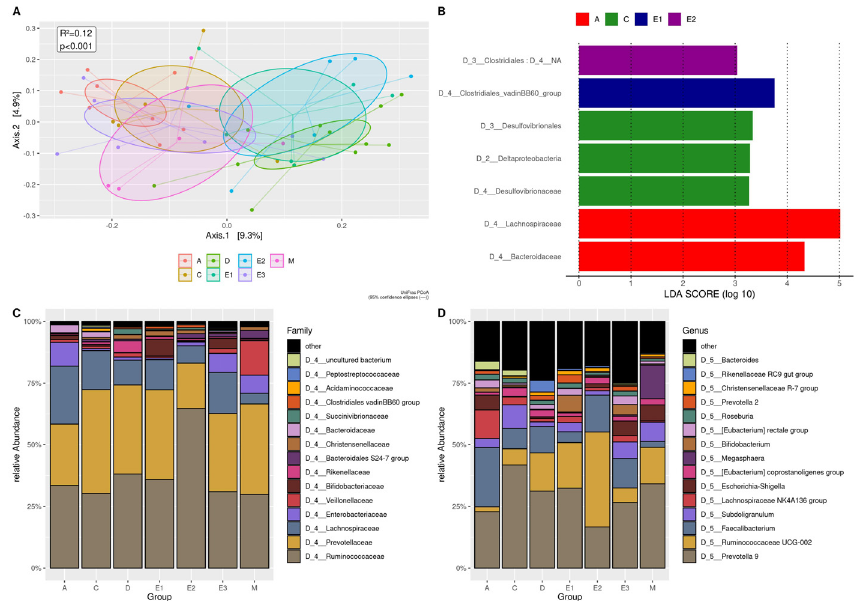
Figure 7. Beta diversity analysis for the subjects positive for G. duodenalis and other intestinal pathogens. Groups A: control group; Groups C: positive for Blastocystis only; Groups D: positive for Blastocystis and E. hartmanni without other pathogens; Groups E1: positive for E. hartmanni, Blastocystis and G. duodenalis , and pathogenic bacteria and viruses; Groups E2: positive for En. coli, Blastocystis and G. duodenalis , and pathogenic bacteria and viruses; Groups E3: positive for Blastocystis, G. duodenalis , and pathogenic bacteria and viruses; Groups M: positive for Blastocystis and mixed infection of pathogenic bacteria and viruses, without G. duodenalis and Entamoeba spp. ( A ) PCoA UniFrac showing low divergences along Axis 1 (9,3%) between positives with Blastocystis and E. hartmanni without pathogens (Group D) and Groups E1 and E2 including positives for G. duodenalis and other intestinal microorganisms. ( B ) Histogram of the linear discriminant analysis (LDA scores indicate the higher difference between clades of A, C, E1, and E2 groups. ( C ) The plot